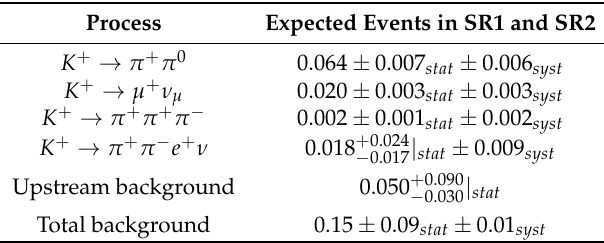
Table 1. Summary of the background estimation for the K + → π + ν ¯ ν analysis on 2016